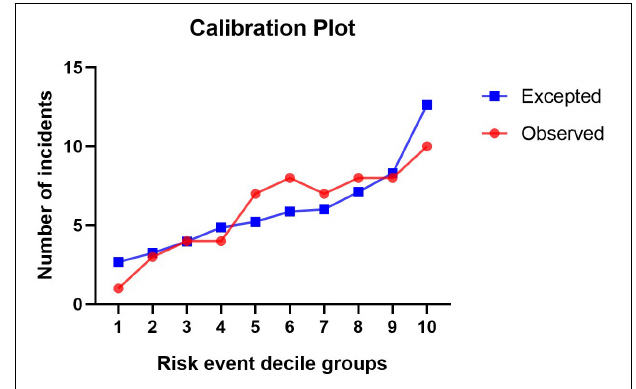
FIGURE 4 | Calibration plot of the model for predicting massive